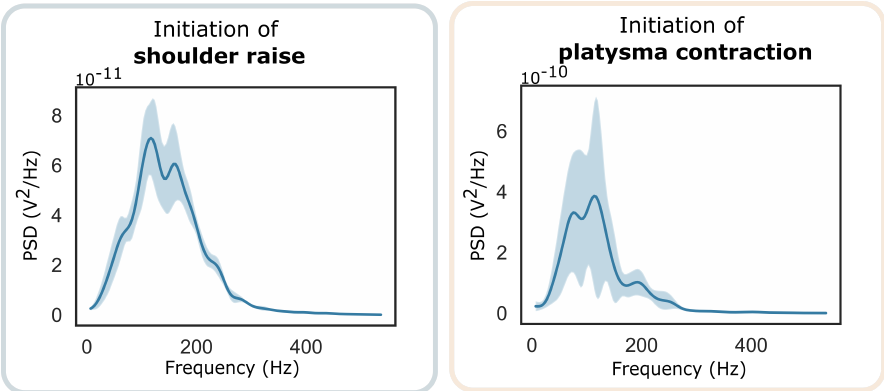
Figure 2. The average PSD of the platysma muscle sEMG signal around the points of contraction during five shoulder raise instances ( left ) and five platysma contraction ( right )